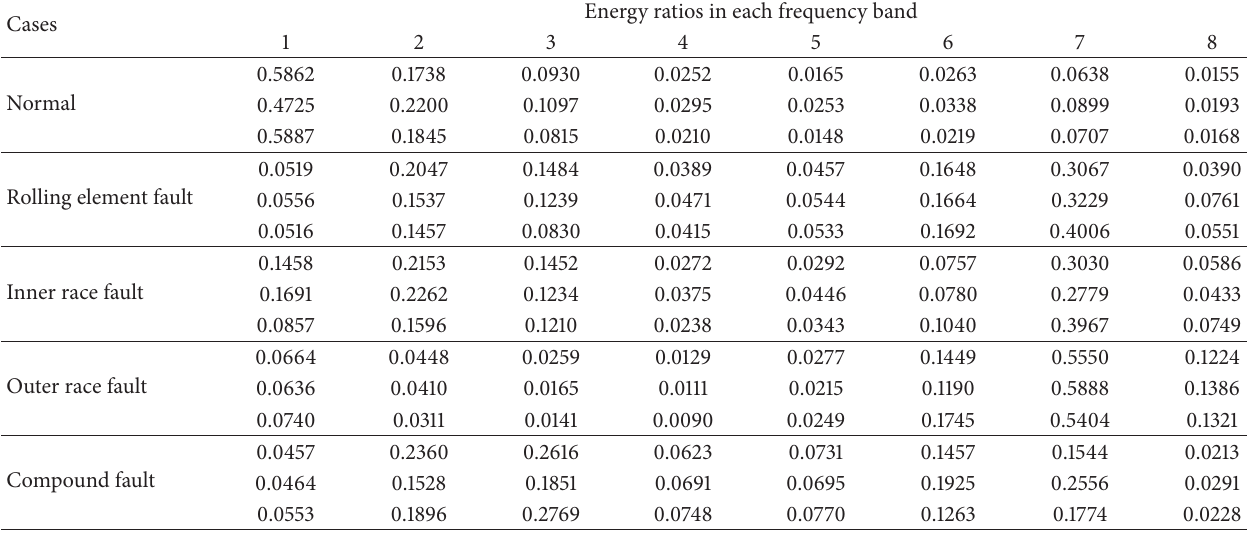
Table 1: Bearing training samples.